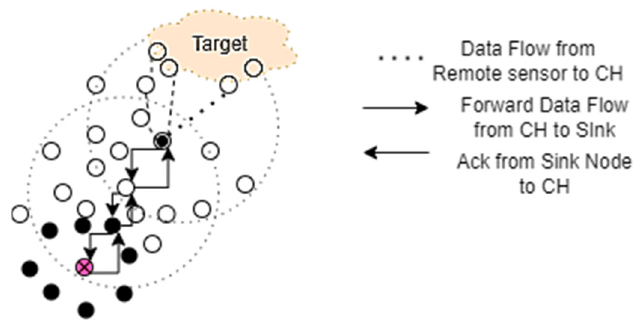
4.4. Data Dissemination